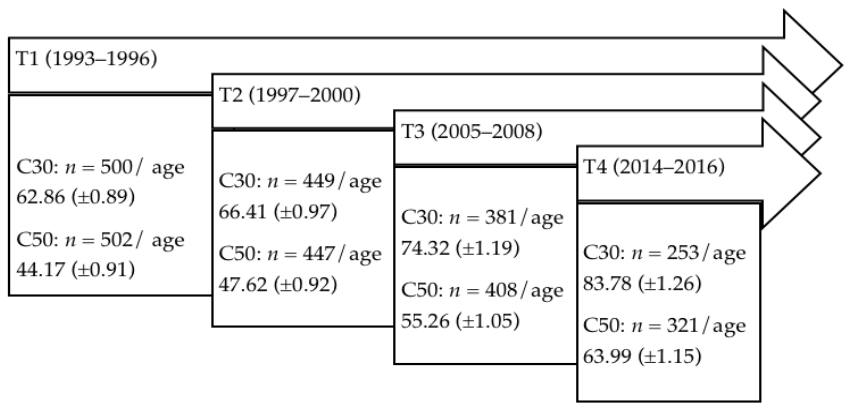
Figure 1. Examination waves of the Interdisciplinary Longitudinal Study of Adult Development and Aging .